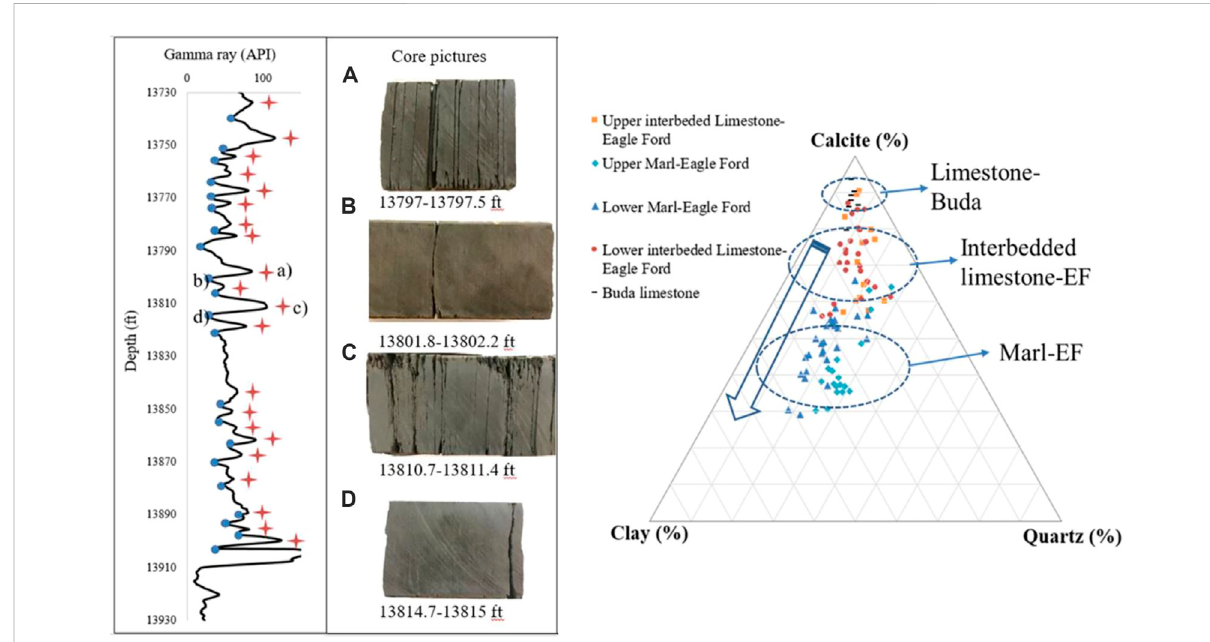
FIGURE 2 Left: Marl and limestone layers of the Eagle Ford Formation in Dewitt County, Texas (A,C) Core samples from marl layers; (B,D) core samples from limestone layers. Right: Ternary plot of the marl and limestone layers in the Eagle Ford and Buda